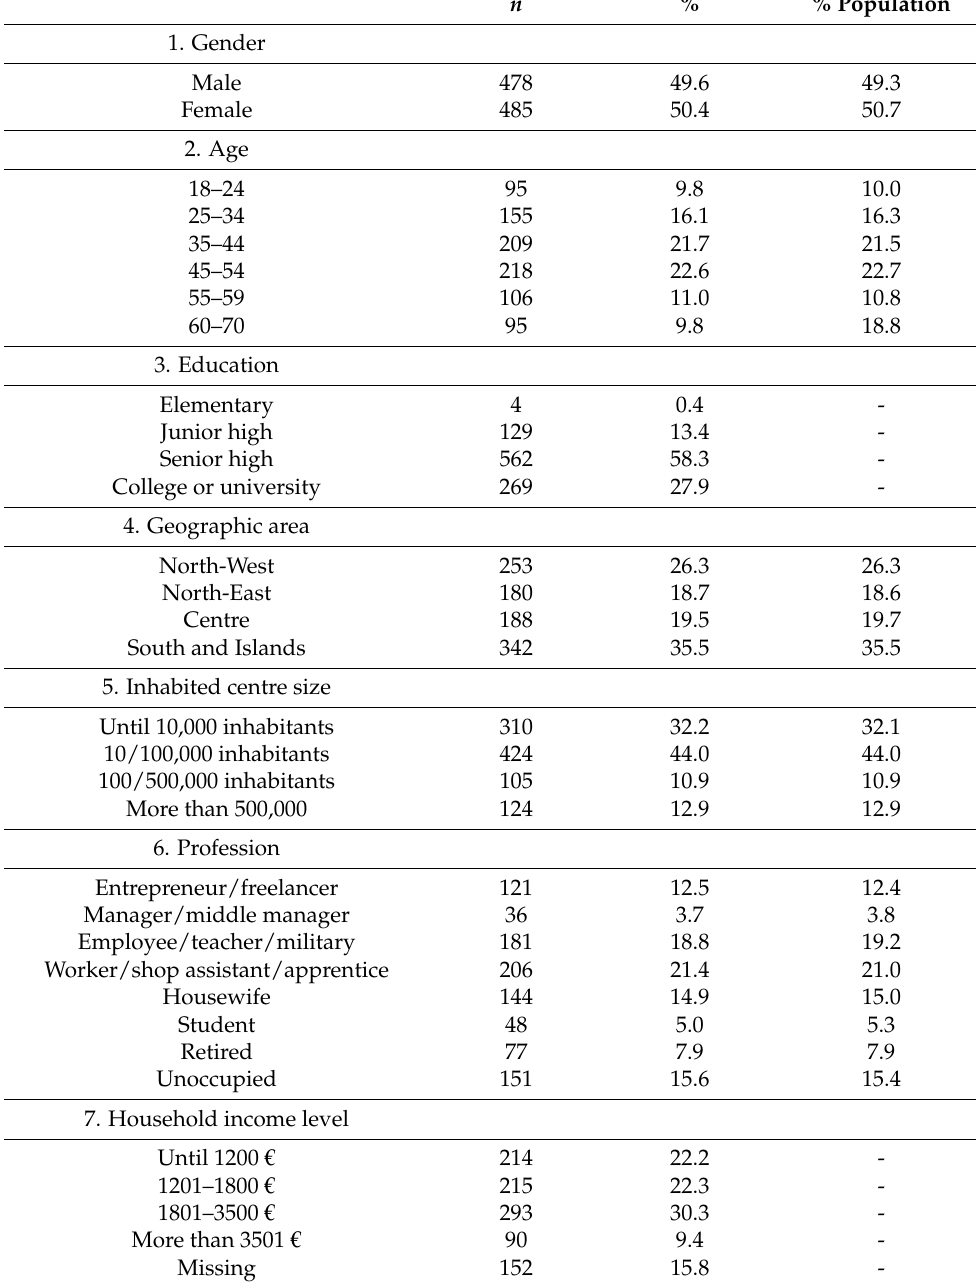
Table 1. Demographic profiles of the sample ( n =